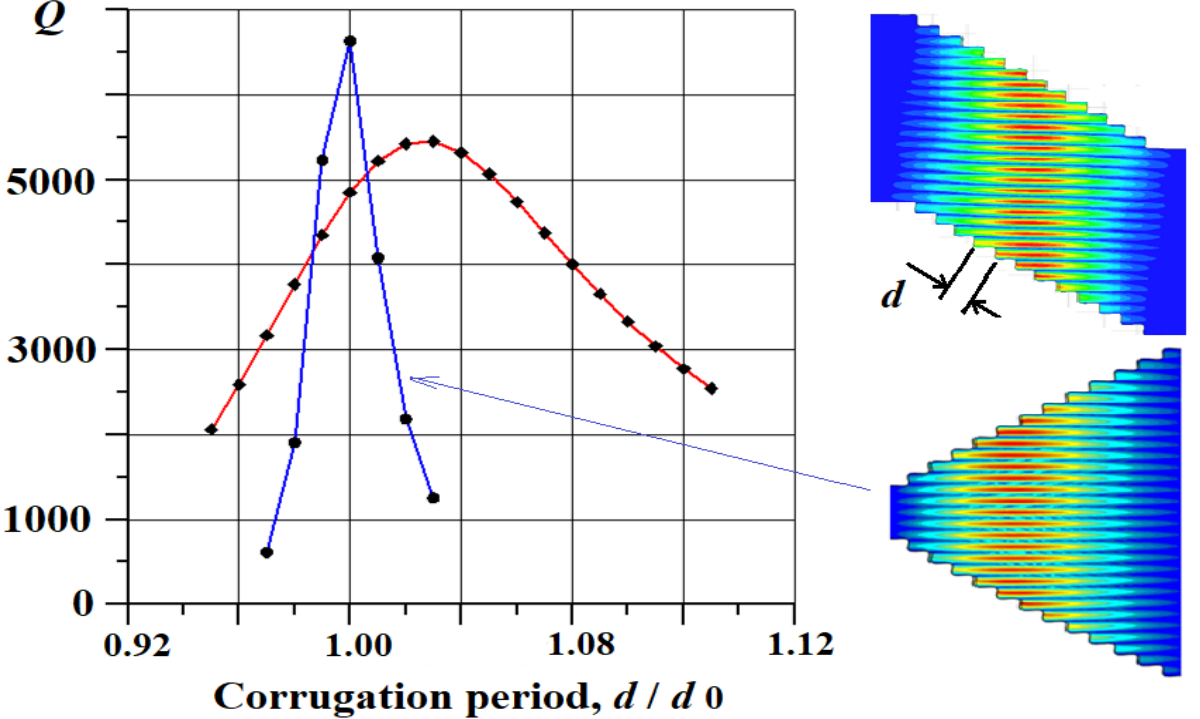
Figure 6. Mode Q-factors of the echelette-type cavity (blue curve) and the cavity formed by two parallel gratings (red curve) as functions of corrugation period with the number of corrugation grooves staying unchanged.